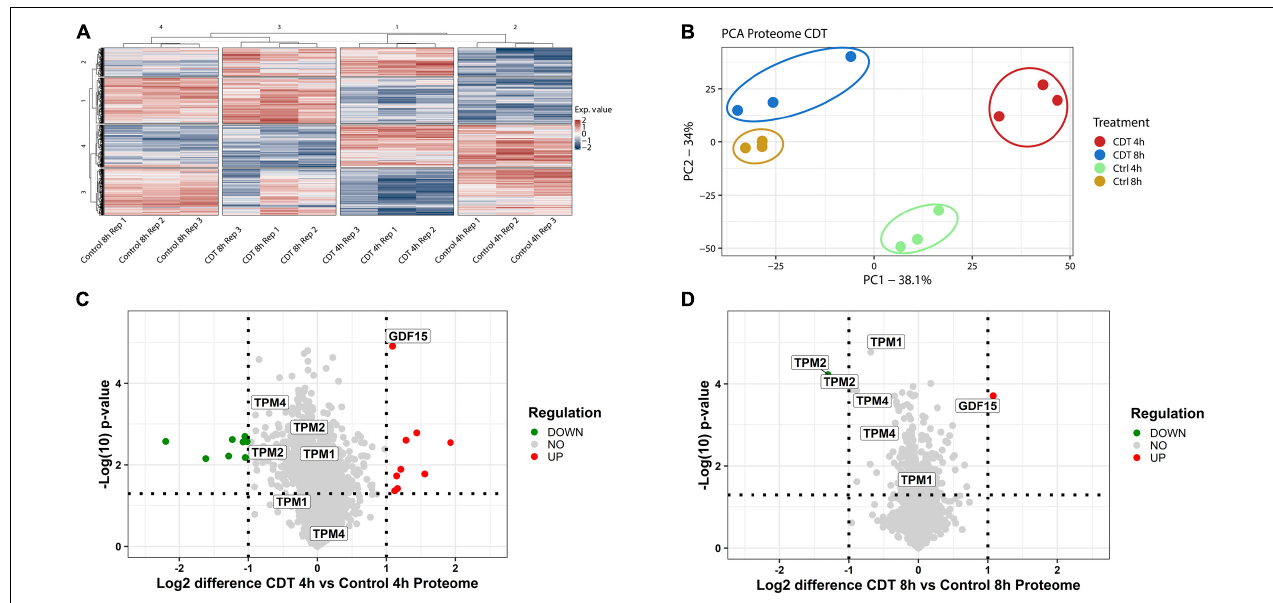
FIGURE 2 | Proteome analysis of with CDT-treated HEp-2 cells after 4 and 8 h. (A) Heat map of proteins that were significantly changed ( p < 0.05) after Benjamini Hochberg FDR-based ANOVA testing. (B) Principal component analysis (PCA) of proteins that were significantly altered ( p < 0.05) after FDR-based ANOVA testing. Volcano plots of proteins with CDT treated Hep-2 cells after 4 h (C) and 8 h (D) , respectively. Proteins that have been labeled with the same name resemble the isoform of that protein (C,D) . [ (C,D) Horizontal dotted line indicates a p -value threshold of p < 0.05, vertical line a twofold difference, green dots: twofold significant downregulation, red dots: twofold significant upregulation; (A) Exp. value: expression value; numbers of row and column cluster are for coordinative reasons and have no underlying meaning; (B) PC1: principal component 1; PC2: principal component 2].